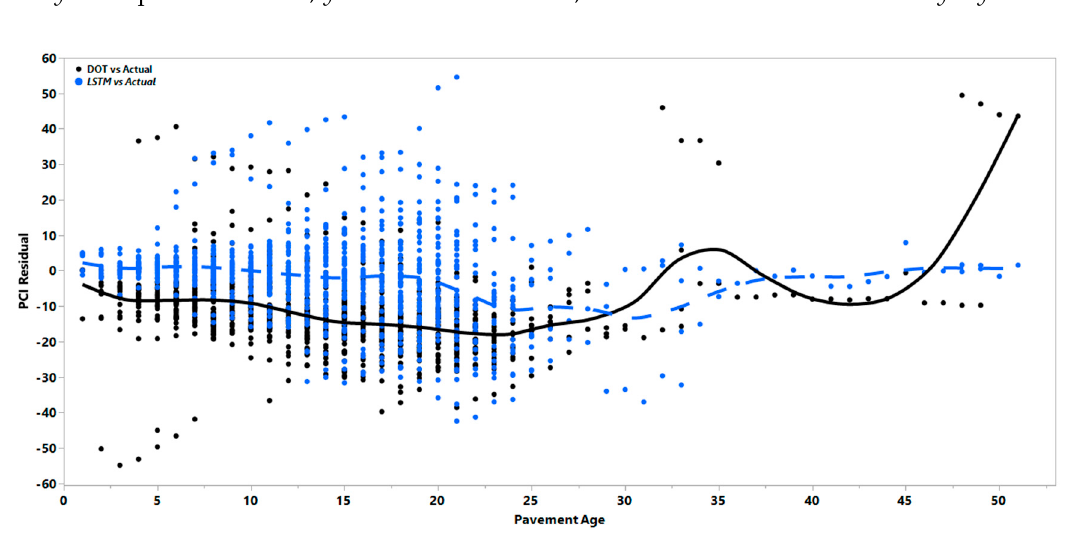
Figure 8. PCI residual vs. age in COM pavements. Figure 9. PCI residual vs. age in PCC pavements.